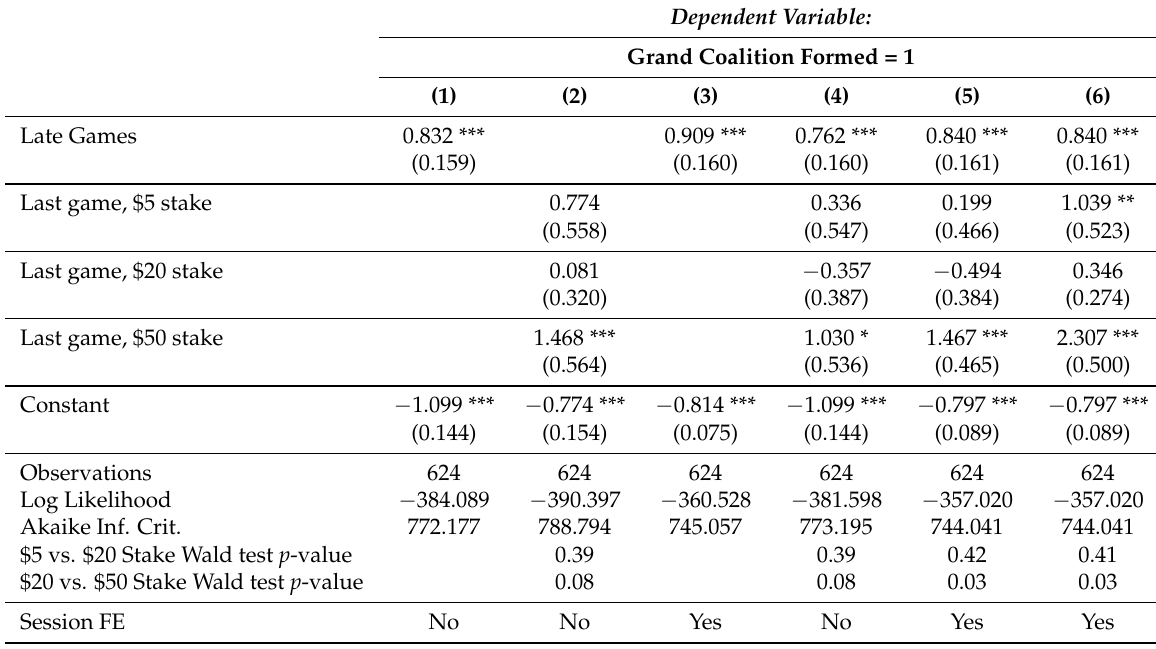
Table 2. Probability of a grand